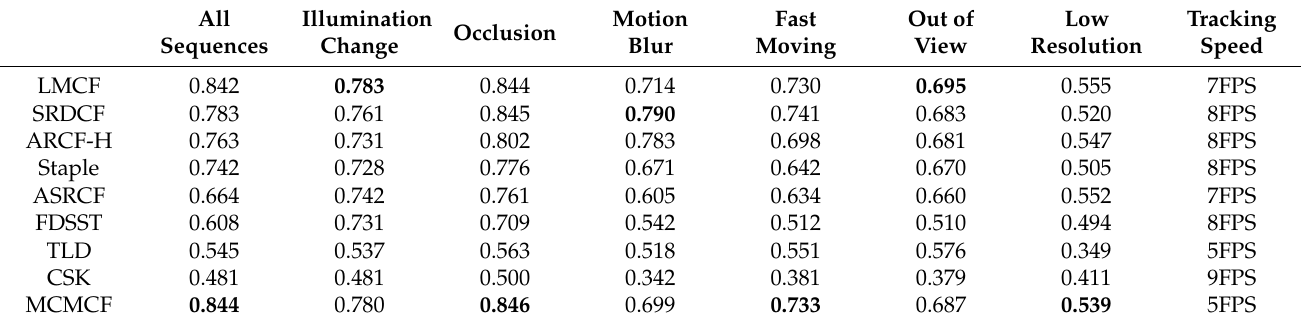
Table 2. Comparison of the precision and tracking speed of different tracking algorithms on the dataset with occlusion on OTB2015.